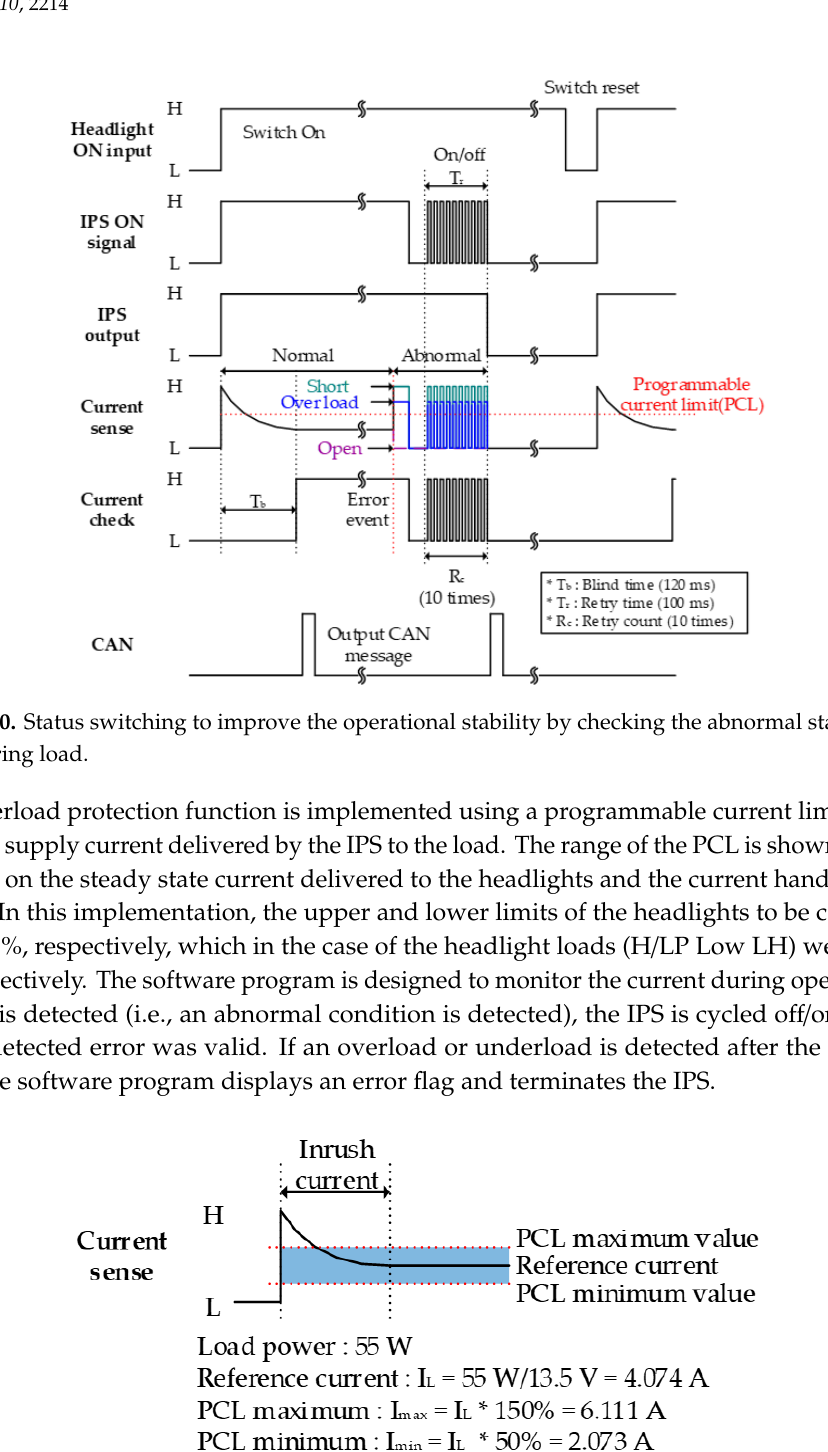
Figure 12. Test environment. 3.1. Load Operation Test (On/Off Control) A driving test was conducted for each headlight load to evaluate the characteristics of the load. The voltage drop was measured based on the current output by the SJB, the length of the wire, and